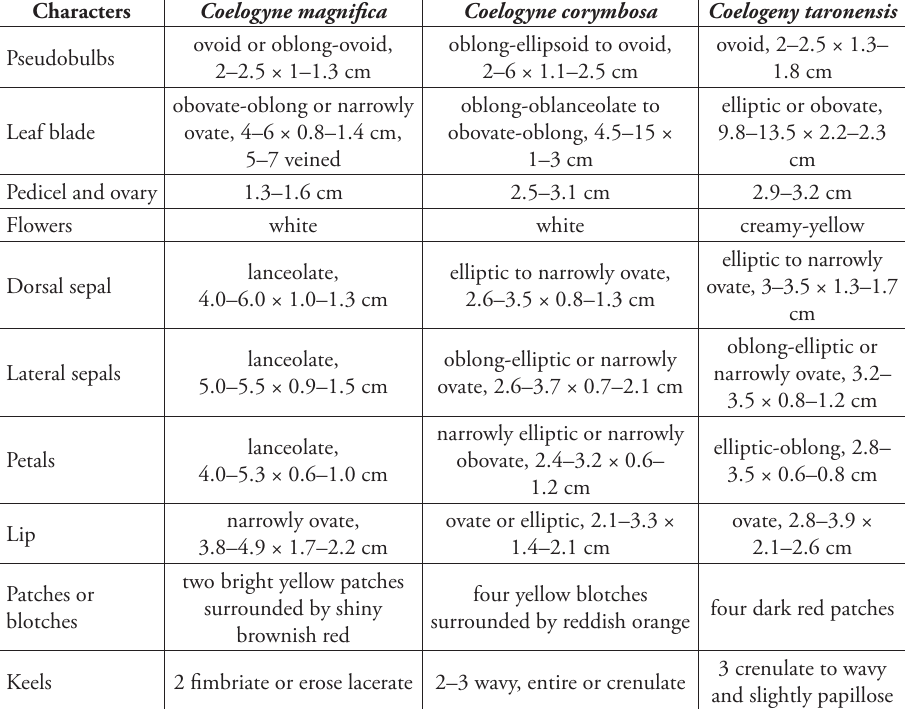
Table 1. Morphological comparison of Coelogyne magnifica and its closely related